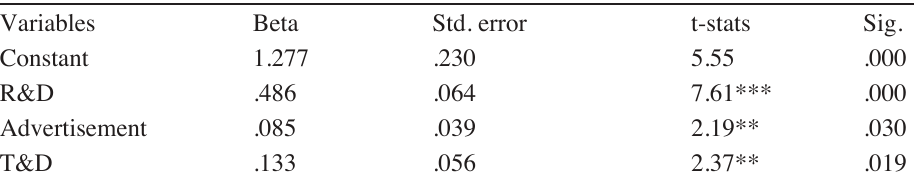
Table 4. Regression Results